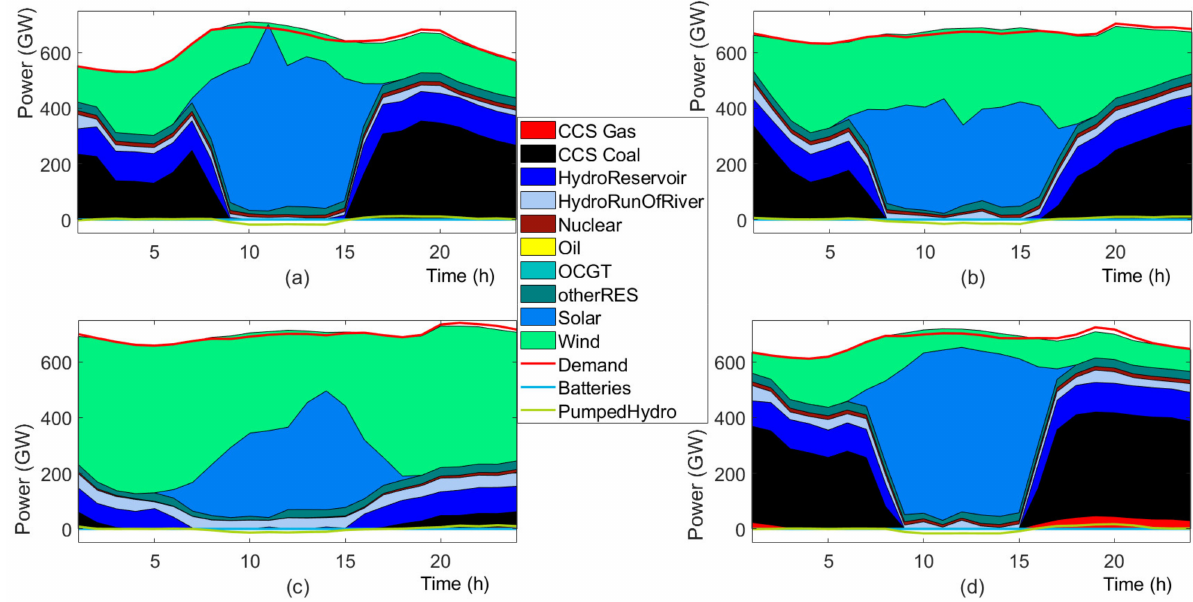
Figure 14. Generation mix in the year 2050 (specifically, scenario-tree node 11), without the availability of storage, in four typical days. Figure ( a ) reports a typical day within the period January–March, ( b ) a typical day within April–June, ( c ) a typical day within July–September, and ( d ) a typical day within